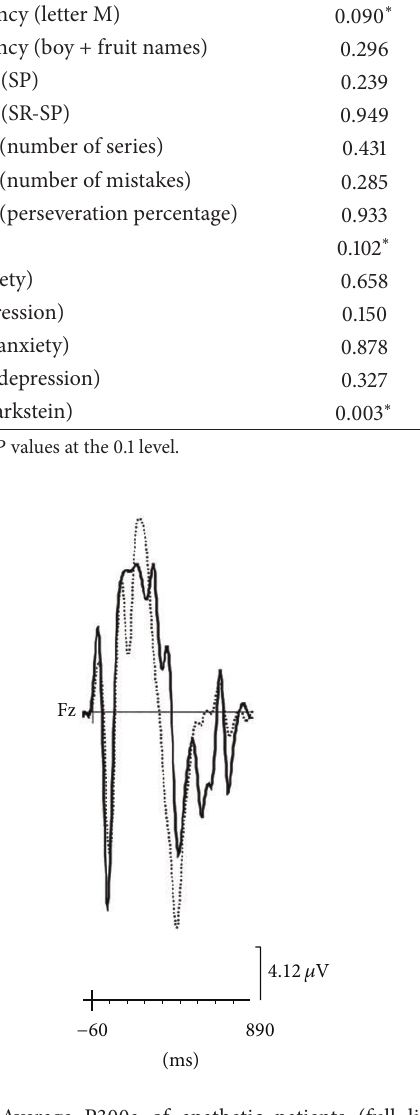
Figure 3: Average P300a of apathetic patients (full line) and nonapathetic patients (dotted line) during ON period (in Fz